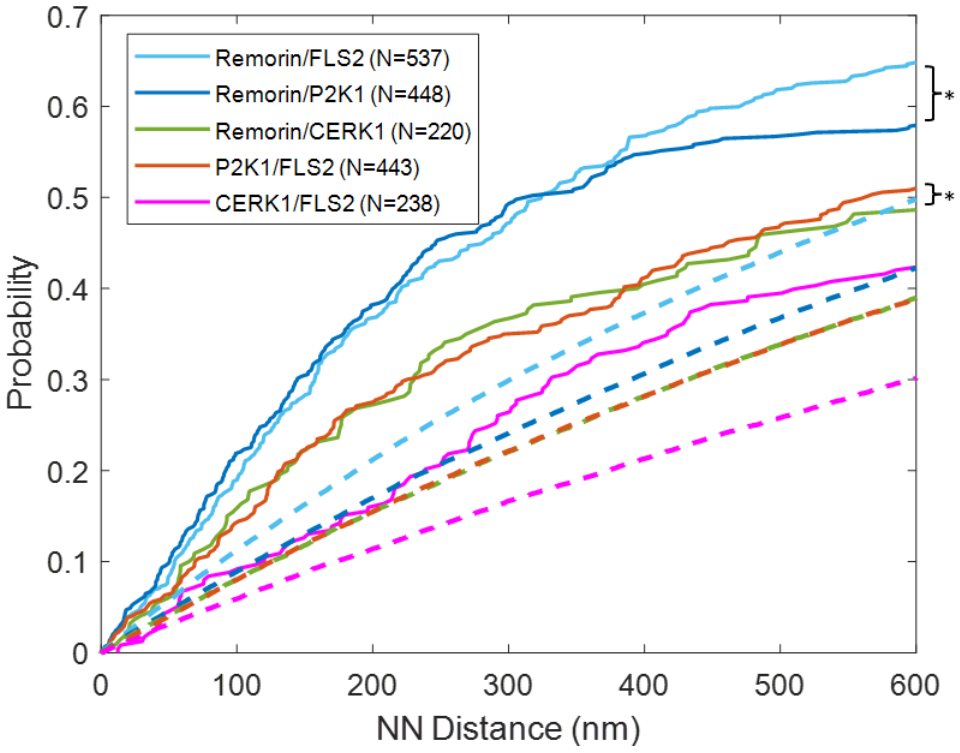
Figure 6. Cumulative distribution function distances from each identified FLS2 to its nearest-neighbor protein in the other channel, or from P2K1 or CERK1 to remorin. Dashed lines indicate simulated nearest-neighbor distances. Asterisk pairs indicate two-sided Kolmogorov–Smirnov significance similarity >0.05 for nearest-neighbor distance below 500 nm.